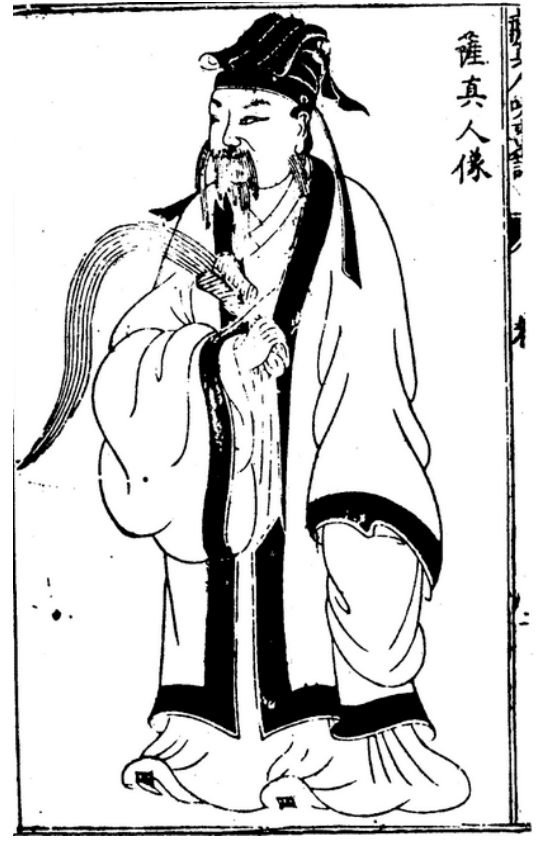
Figure 6. A portrait of Sa Shoujian in The Enchanted Date , 1603.